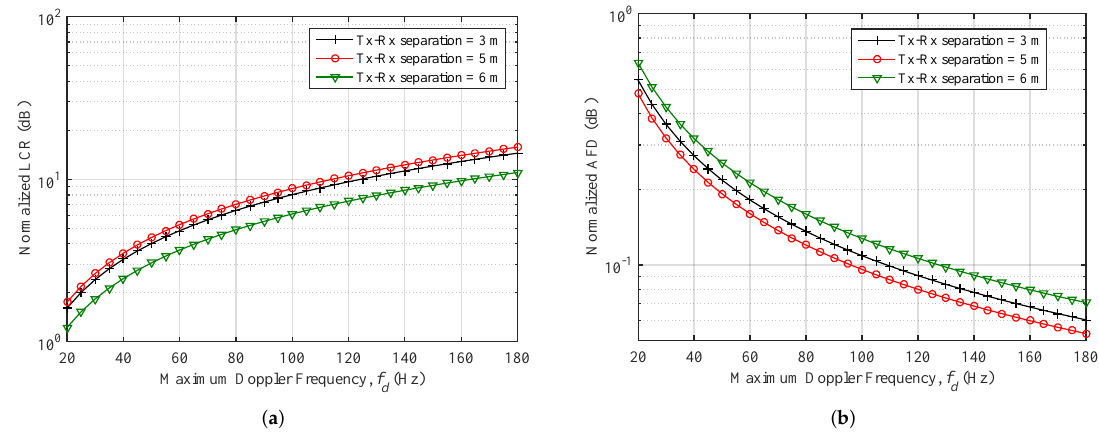
Figure 8. LCR and AFD plotted against different values of maximum Doppler shift in ( a , b ), respectively; for different scenarios of indoor mmWave (Case 2 (b); 38 GHz) radio propagation environments. ( m = 1, ρ = 2).